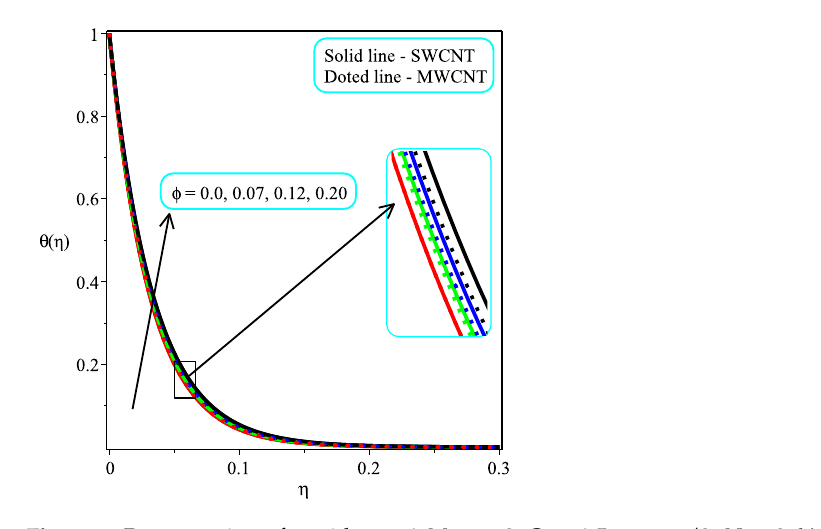
Figure 5. Repercussion of φ with κ = 1 M egt = 2, Ω = 1.5, ω = π /3, N = 2, Υ = 0.4, Pr = 100 on the temperature